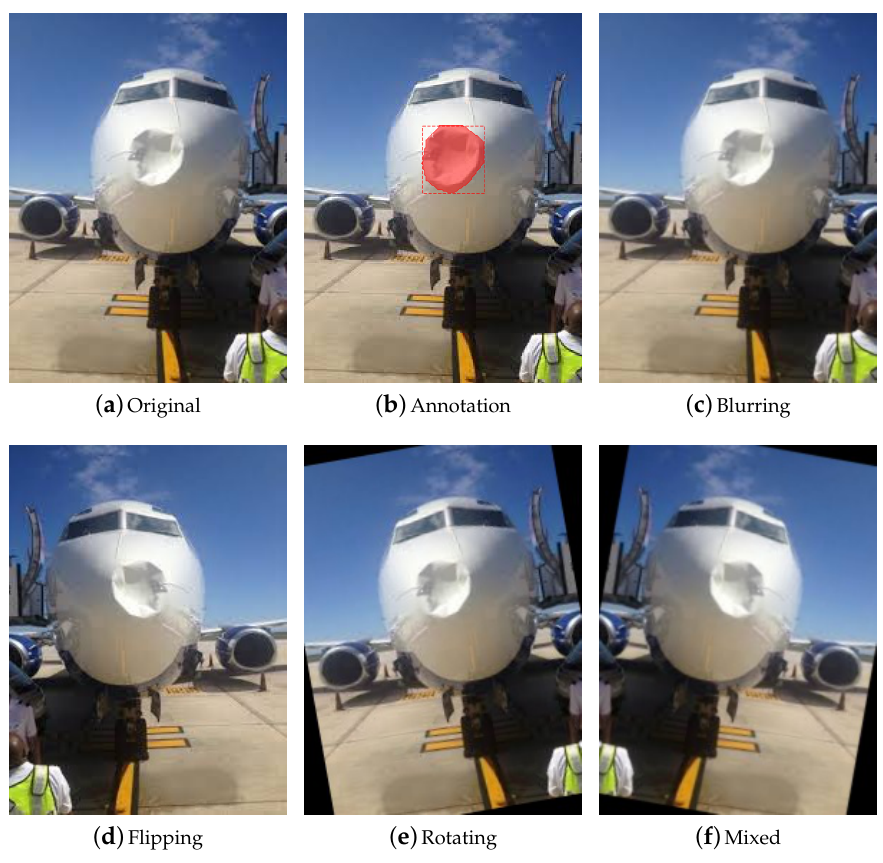
Figure 3. Example illustrating how the selected augmentation techniques preserve the dents in the image.